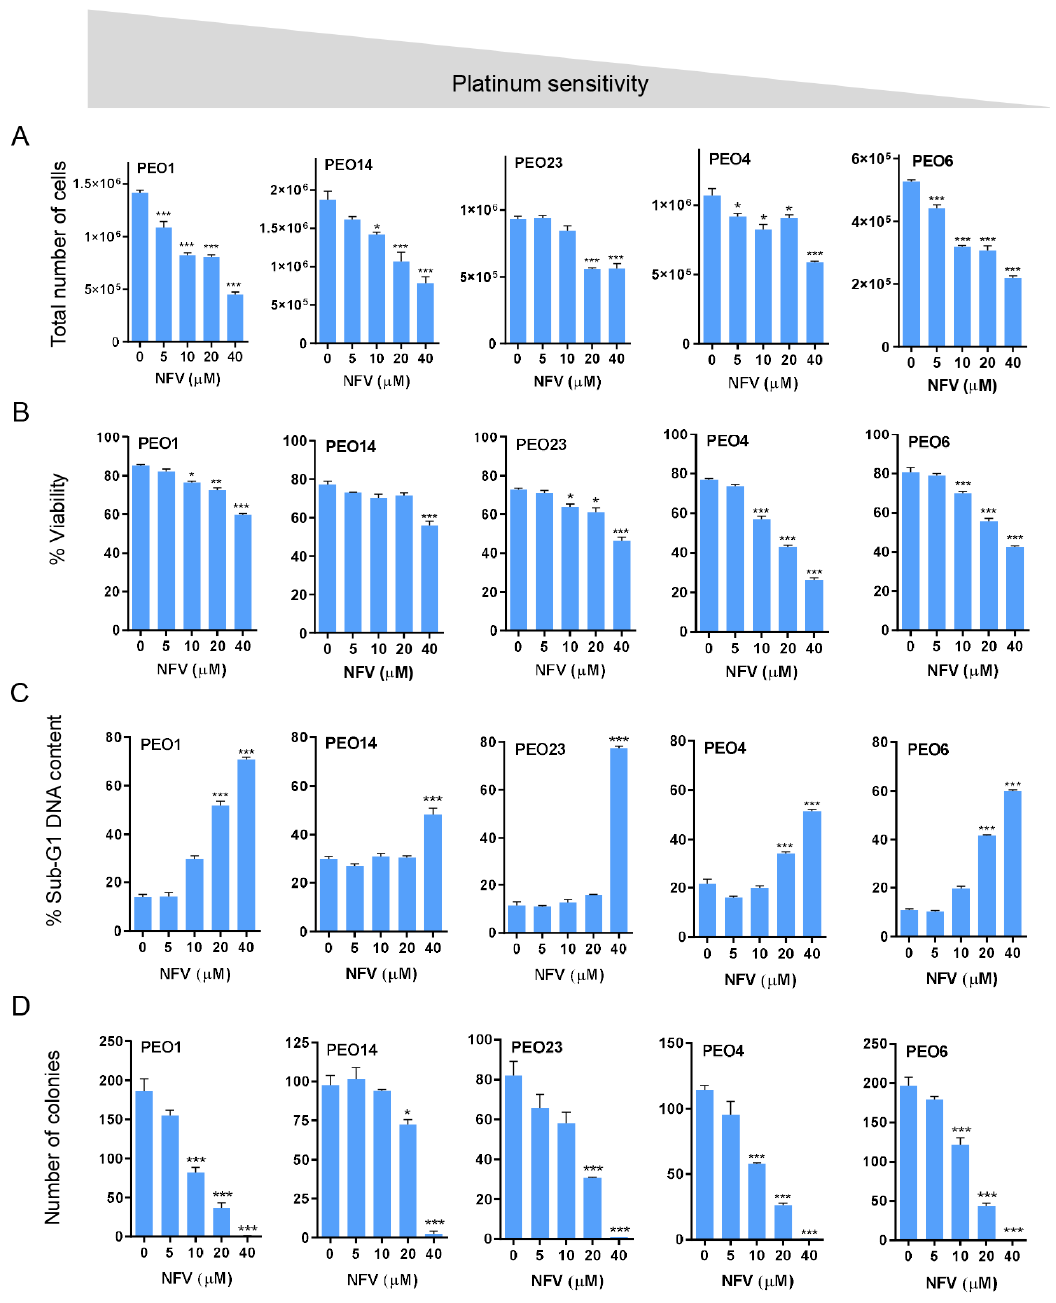
Figure 1. HGSOC cells of differential platinum sensitivities were plated in six-well plates in triplicate and, when exponentially growing, were subjected to treatment with the depicted concentrations of nelfinavir (NFV) for 72 h. At the end of the experiment, the cells were trypsinized and subjected to microcytometry analysis to attain total number of viable cells ( A ) and percent viability ( B ). A fraction of the cellular content collected at the end of the incubation with NFV was stained with a solution of propidium iodide (PI) and subjected to cell cycle analysis to determine hypodiploid DNA content ( C ). Finally, 1000 viable cells obtained at the end of the experiment were subjected to a clonogenic survival assay in the absence of treatment to determine delayed toxicity of NFV ( D ). * p < 0.05; ** p < 0.01; *** p < 0.001 vs. control (one-way ANOVA followed by Tukey’s Multiple Comparison Test). The gray area that goes from higher to lower signifies that the cells are depicted in order of their decreasing sensitivity to the toxic effects of cisplatin as presented in Table